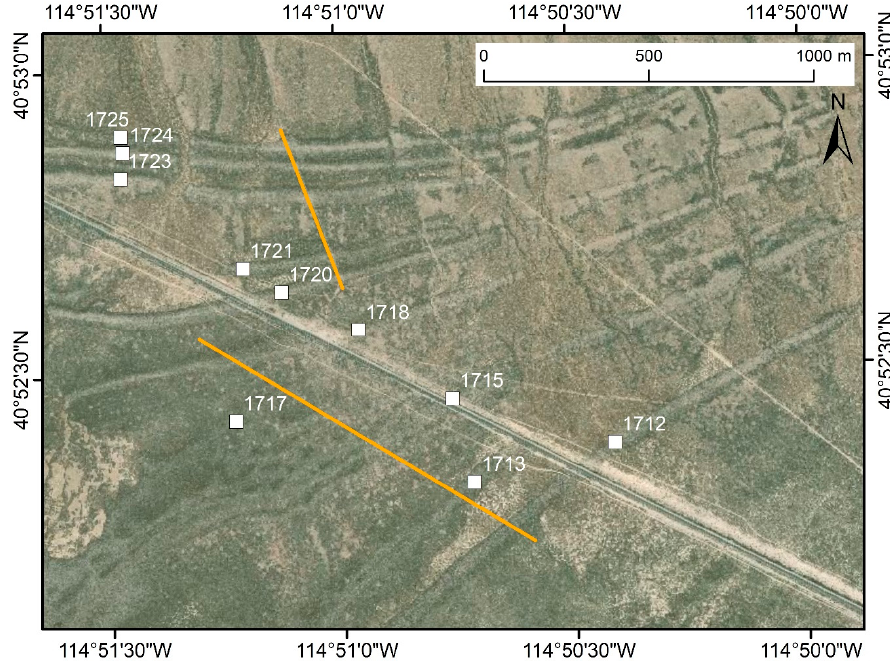
Figure 2. True color aerial image of the Tobar transect study area. Ten separate shoreline berms are obvious as linear features extending from the upper right to lower left. Color contrast reflects the presence of a different vegetation community on the drier, windswept crest of each ridge. The prominent line extending from upper left to lower right is the Union Pacific railroad line. White squares mark the locations of the pits excavated into each of the beach ridges. The corresponding labels indicate the reconstructed elevation of the lake surface (in meters above sea level) at the time when each ridge was constructed. The two orange lines denote the transects along which the topographic cross section (Figure 3) was measured.